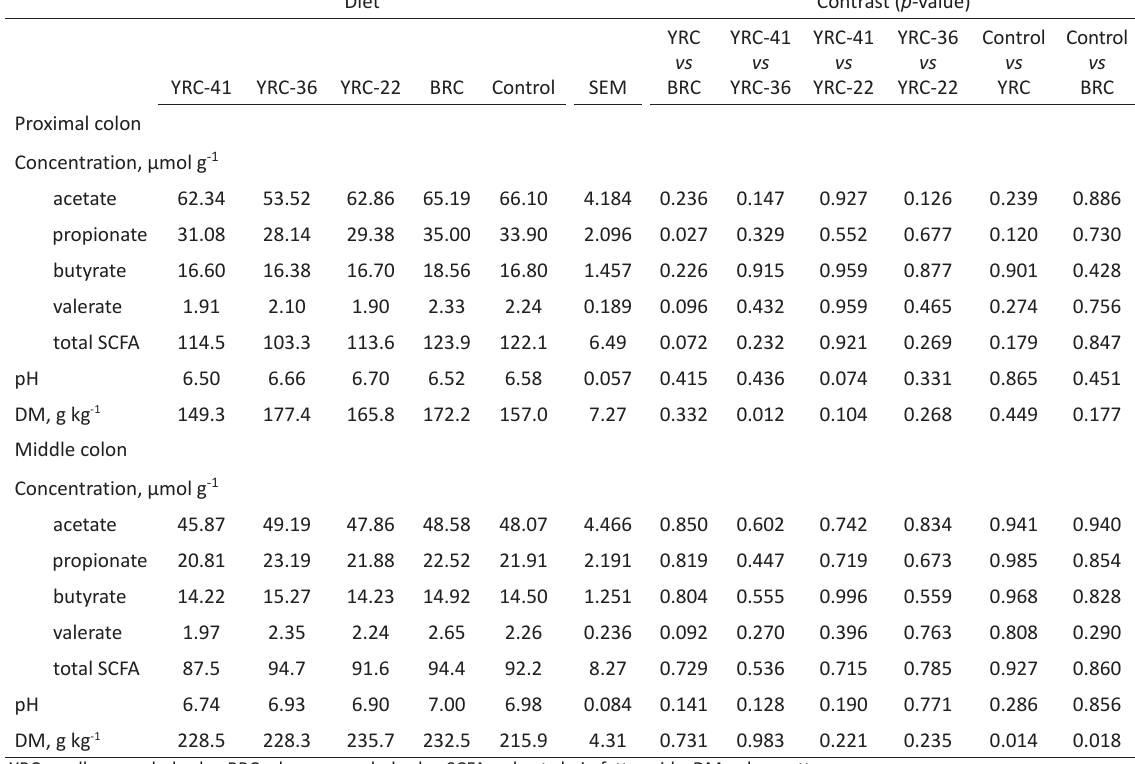
Table 6. Short-chain fatty acids concentration (µmol g -1 ), pH, and dry matter content (g kg -1 ) of colon digesta of pigs fed diets containing